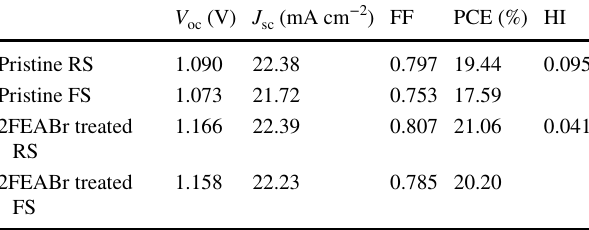
Table 1 Photovoltaic parameters of the champion PSCs with and without 2FEABr under forward scan (FS) and reverse scan